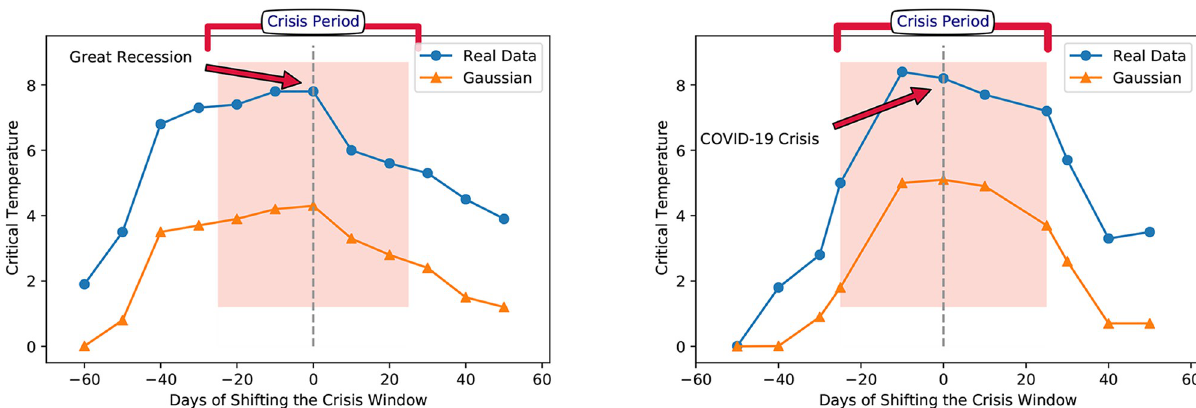
Fig 7. The efficiency of order parameter, Q, versus the correlation in figures a), and b) we consider a moving window that moves from 50 days below the critical point (crisis) to 50 days above and we calculate the critical temperature in each interval of the moving window. The result of studying the structure of the network by the moving window shows that the proposed order parameter is more accurate in predicting crises. It predicts the happening of the crisis sooner and with more intensity rather than correlation.